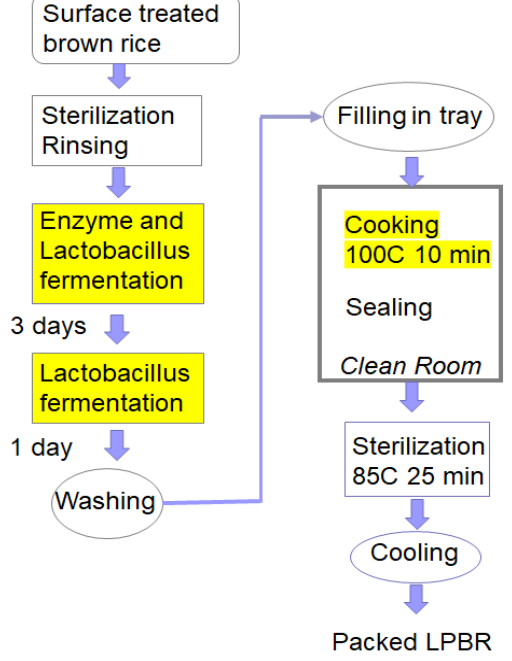
Figure 4. Steps to produce a processed low-protein brown rice.